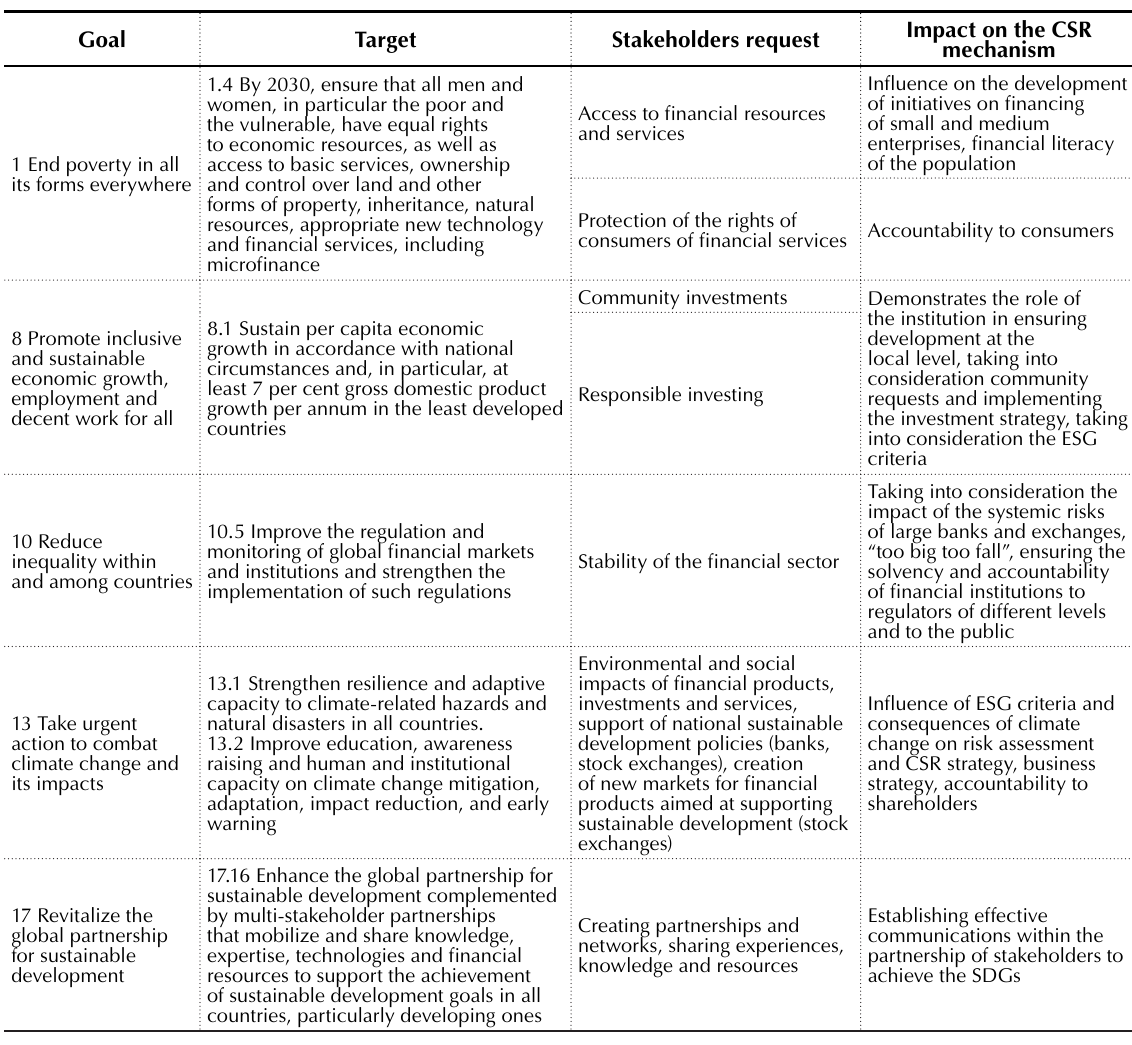
Table 1. The most relevant SDGs related to the provision of financial services and the sale of financial products and their impact on the CSR mechanism